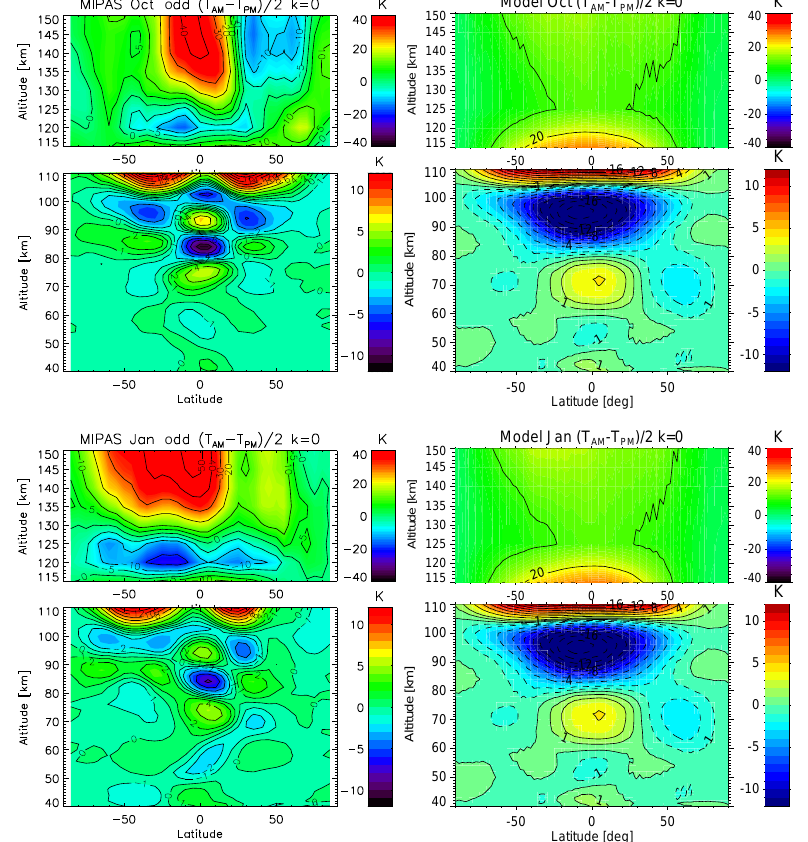
Figure 3. Zonal means of (cid:49)T/ 2 ( | n odd − s | = 0 mode, embedding DW1 and TW3) extracted from average (2007–2012) monthly means of MIPAS T MLT (20–110km) and T THER (115–150km) temperatures (left) compared to corresponding zonal means of the a priori (ECMWF and NRLMSISE-00; see text) (right), for October (first and second rows) and January (third and fourth rows).